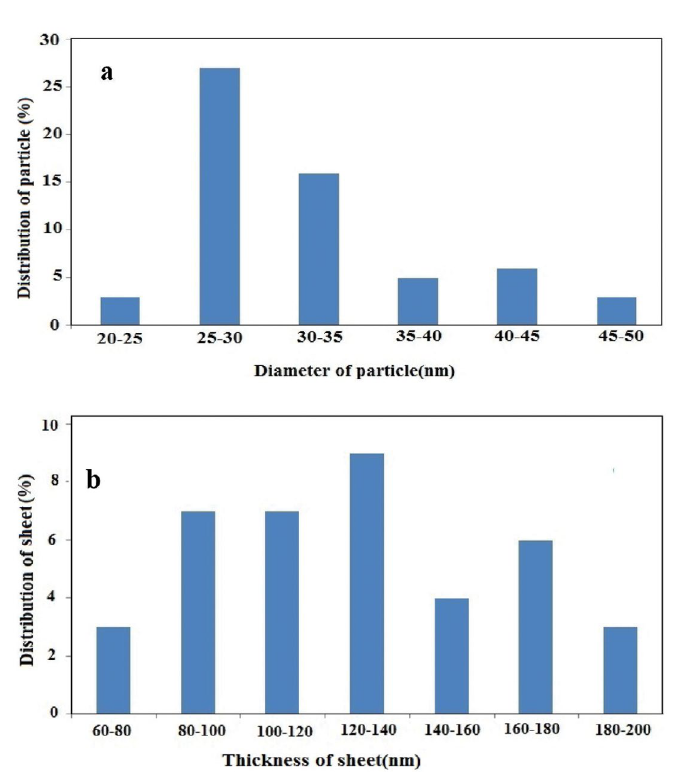
Fig. 7. Histogram plot of a) CdO nanoparticles b) complex (1)